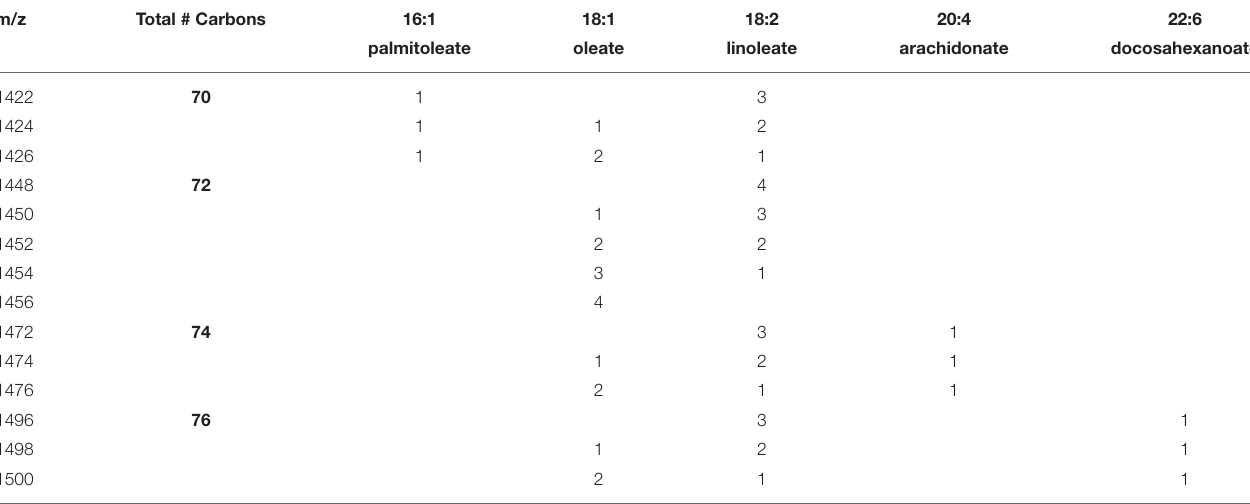
TABLE 1 | Number of each fatty acyl substituent on major species of individual cardiolipins. m/z Total #